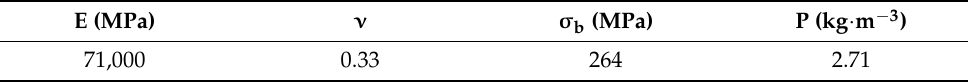
Table 1. Material parameters.